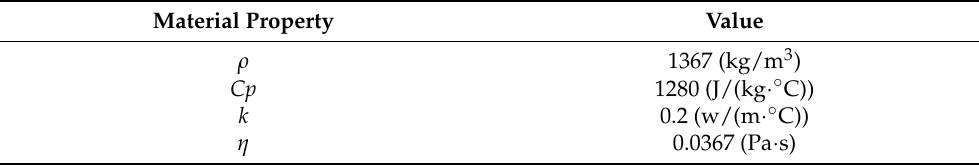
Table 1. Thermo-physical properties of imidazolium salt (Data from Refs. [20,21]).